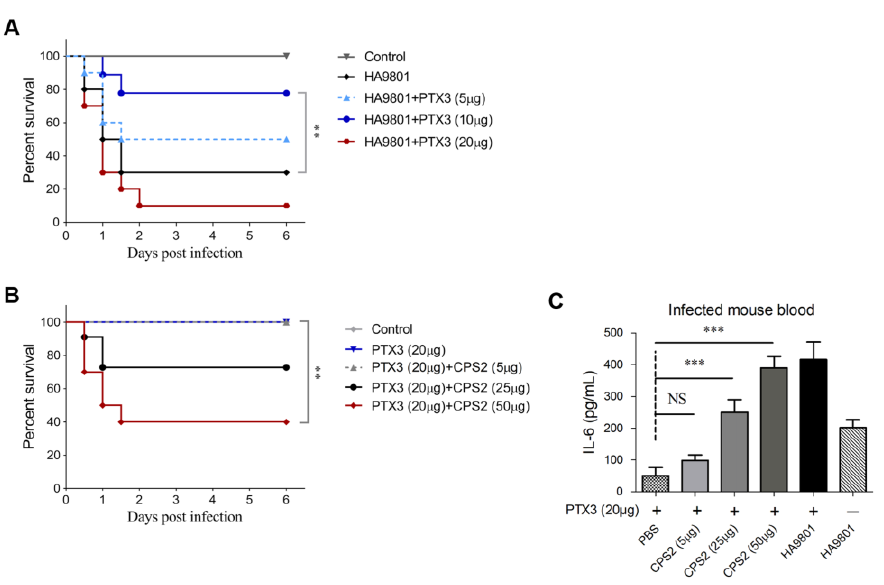
Figure 5. Challenge the protections of PTX3 and CPS2 in mice. ( A ) Survival curves of mice infected by the HA9801 strain with the co-treatment of PTX3 (5, 10 or 20 µ g). ( B ) Survival curves of mice co-treated by PTX3 (20 µ g) and CPS2 extraction (5, 25 or 25 µ g). ( C ) The levels of IL-6 in the bloods of mice co-treated by PTX3 (20 µ g) and CPS2 extractions (5, 25 or 50 µ g). The Log-rank (Mantel—Cox) test was used to analyze the survival curve in the animal experiments. A two-tailed unpaired t test was used for the rest of the experiments. For all tests, a p value < 0.05 was considered statistically significant (** p < 0.01, *** p < 0.001), and all the data were shown as mean ± SEM.